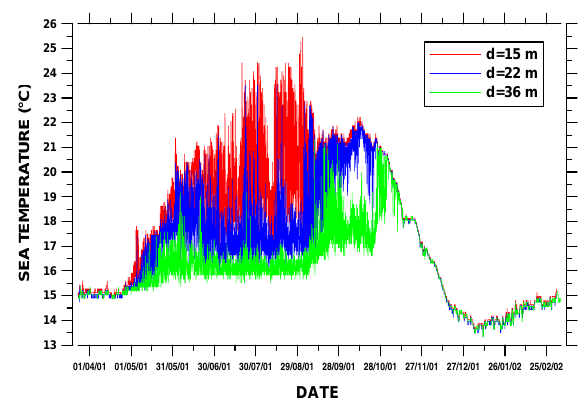
Fig. 2. Original temperature series recorded at the depths of 15, 22 Figure 2. Original temperature series recorded at the depths of 15, 22 and 36 m at Cape Struga, and 36m at Cape Struga, from March 2001 to March 2002. from March 2001 to March 2002.